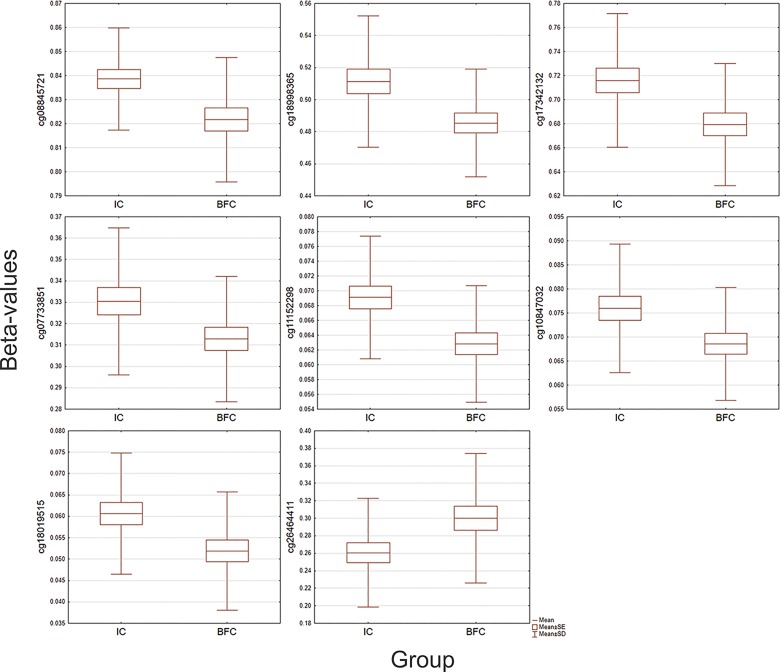
Boxplot graphs illustrating group differences in methylation levels (beta values) for eight CpG sites located within the CGI (chr5:142782071–142785071) associated with the promoter of the NR3C1 (Glucocorticoid Nuclear Receptor Variant 1) gene, which showed a nominally significant (at a p < .05) difference in methylation between the group of institutionalized children (IC) and the group of children raised by their biological families (BFC).